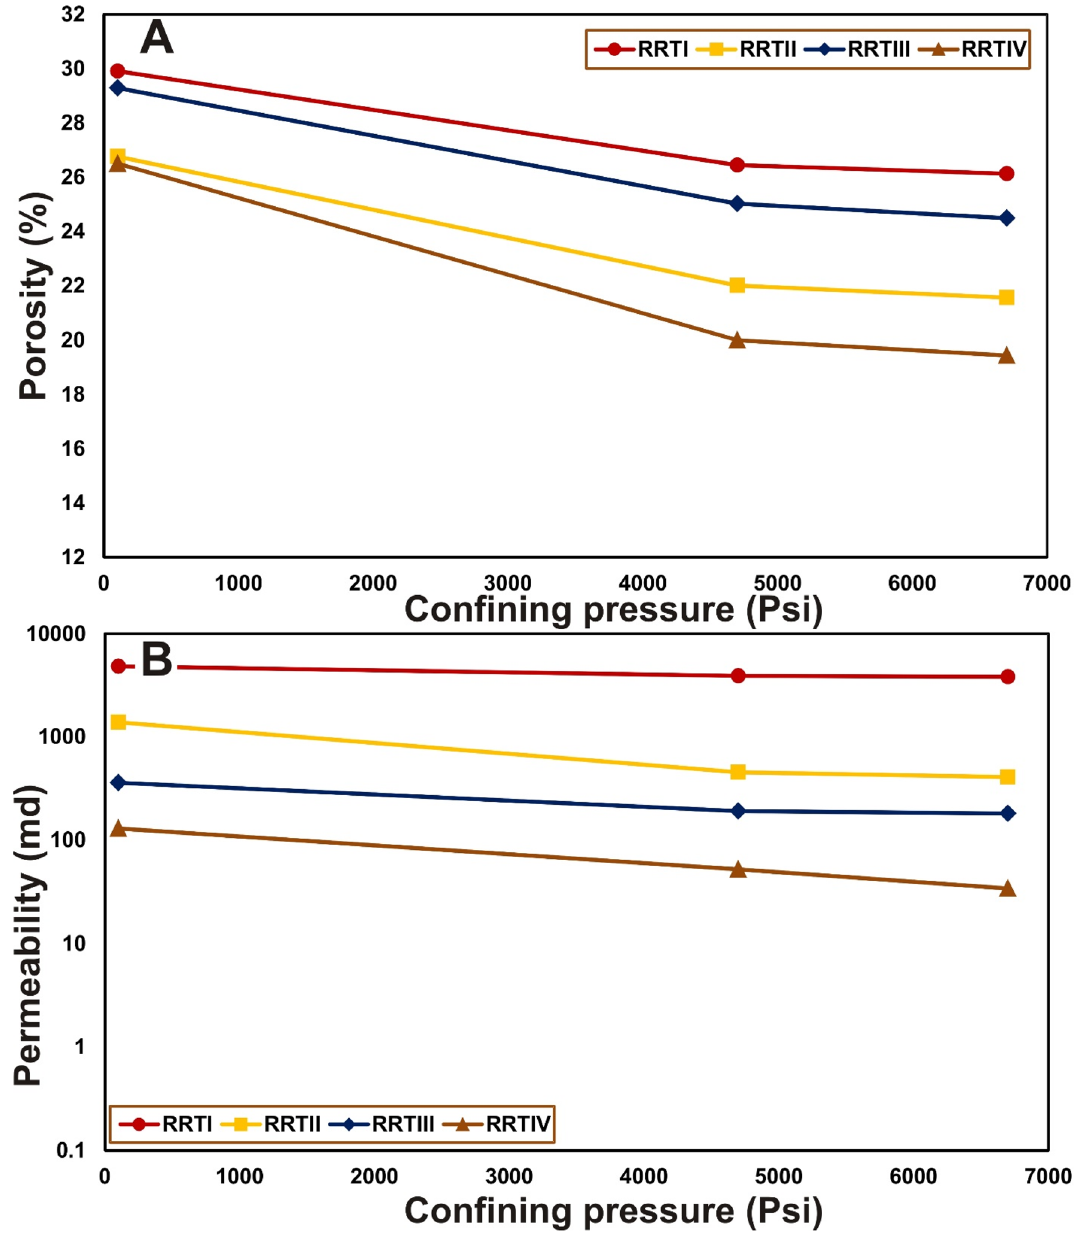
Fig. 16 Effect of confining pressure on porosity ( a ) and permeability ( b ) of the investigated reservoir rock types